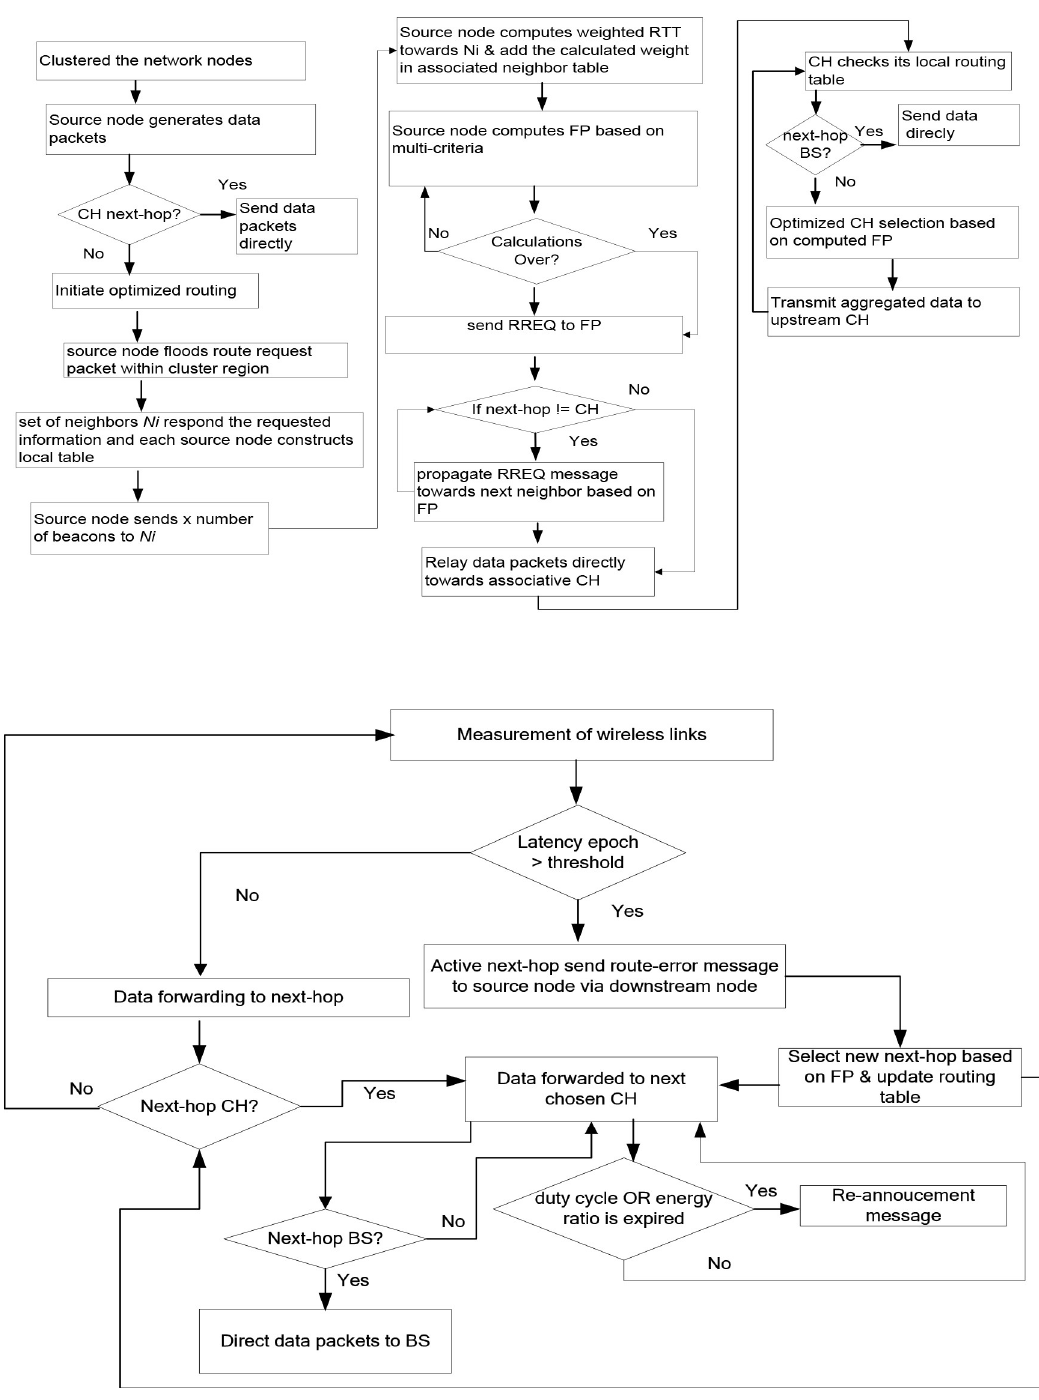
Fig 4. (a)(b) Workflow of RCER protocol. performance of the proposed protocol against existing work. The transmission range of the nodes is fixed to 25m. Table 2 summarizes the default simulation parameters.